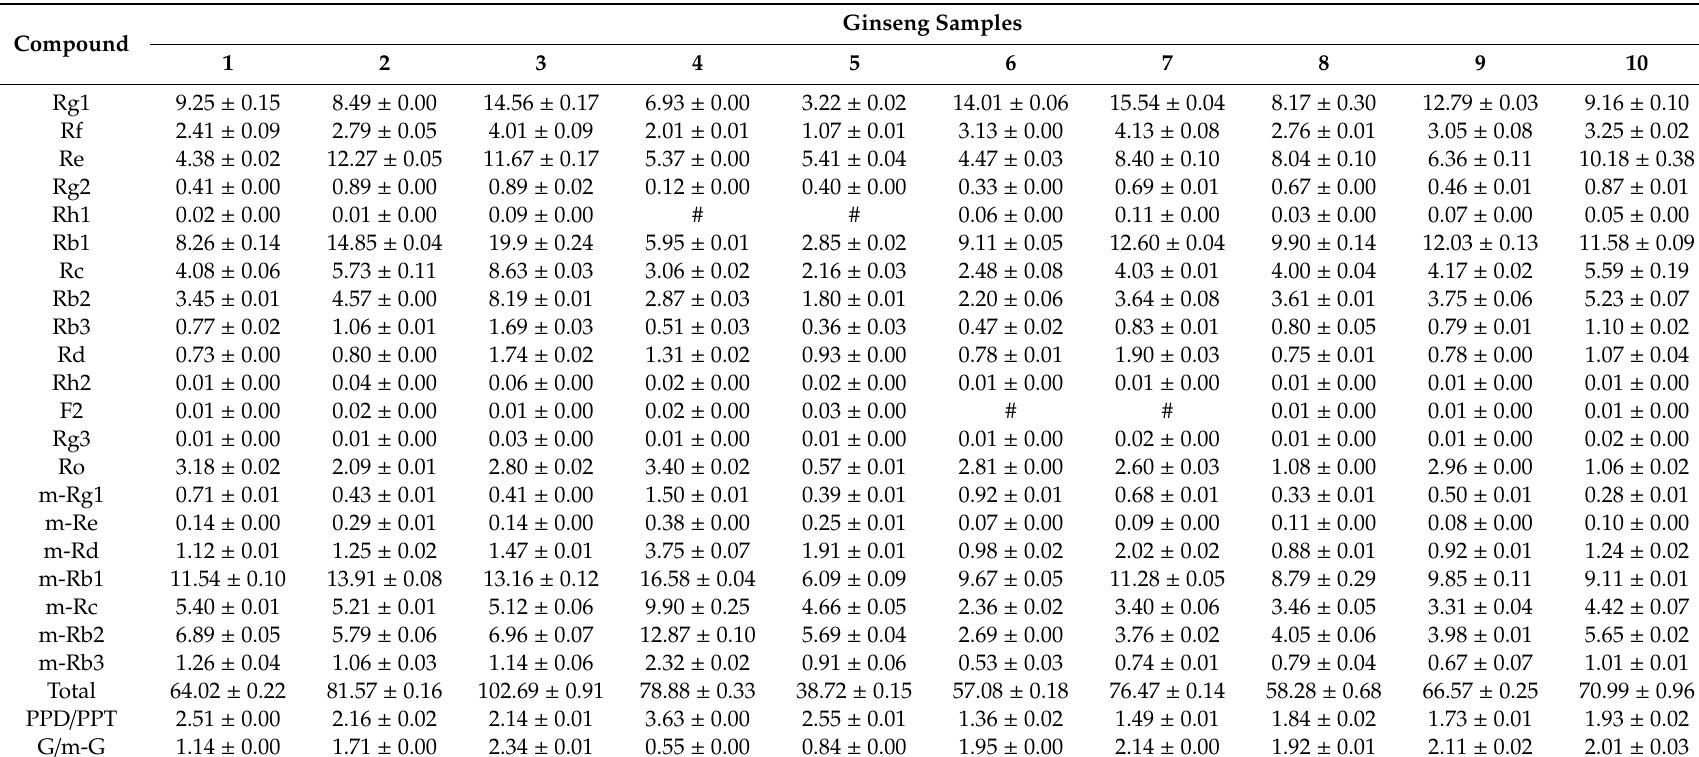
Table 1. The content (mg / g) of ginsenosides in 10 batches of New Zealand (NZ)-grown ginseng samples (mean ±